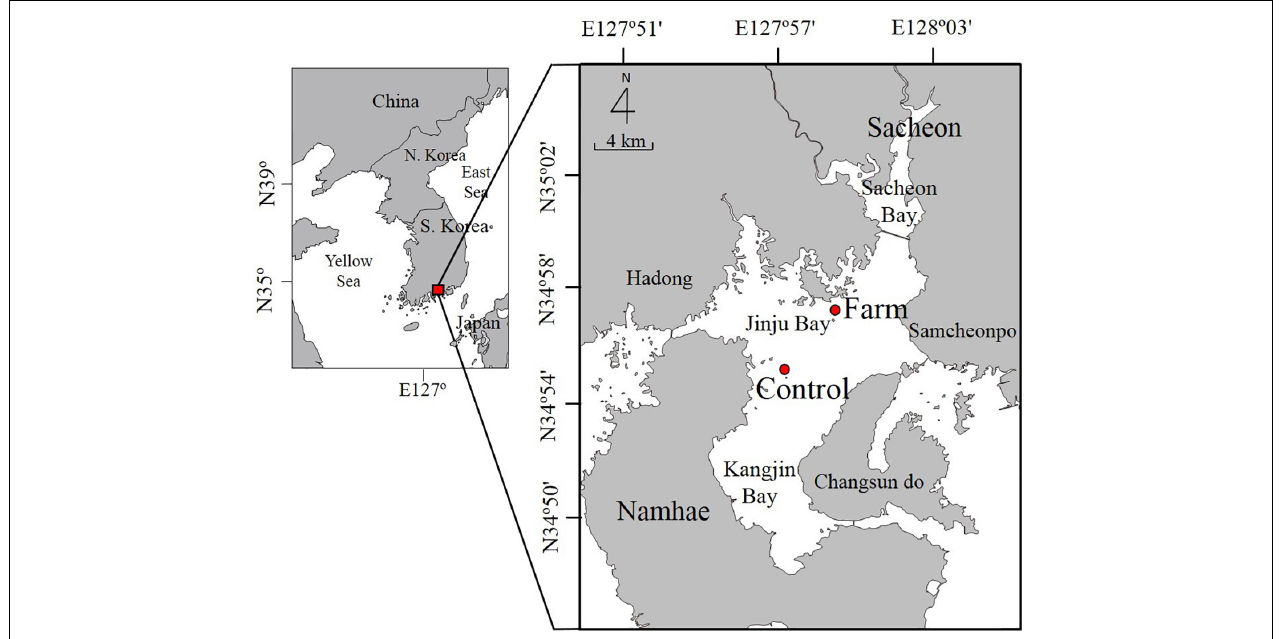
FIGURE 1 | A map showing study sites at the fish farm and control site in Jinju Bay on the southern coast of South Korea. Solid line indicates Sacheon